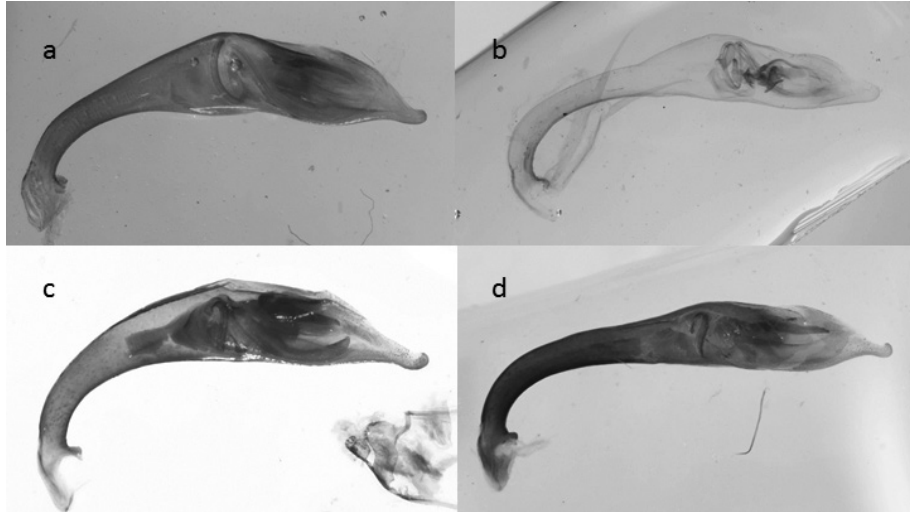
Figure 43. Median lobes of the aedeagus of Cephalota species: a C. littorea b C. tibialis c C. circumdata d C. vartianorum